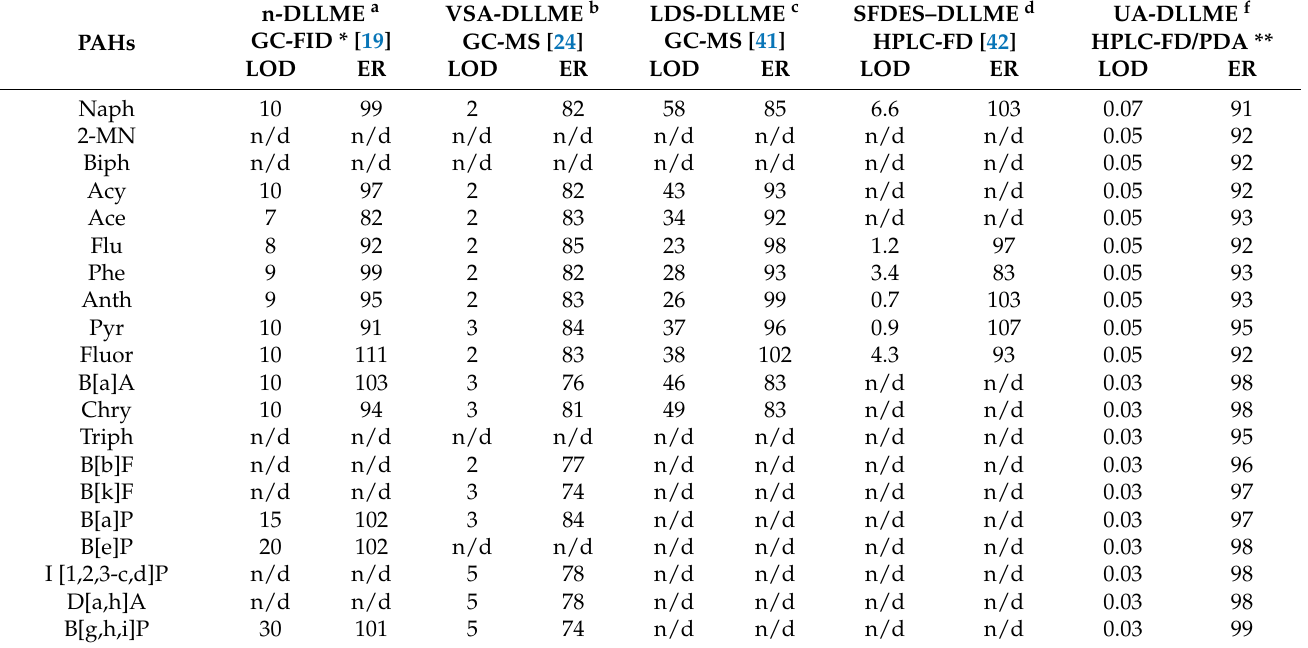
Table 4. The LODs (ng/L) and recoveries (%) of PAHs using various DLLME